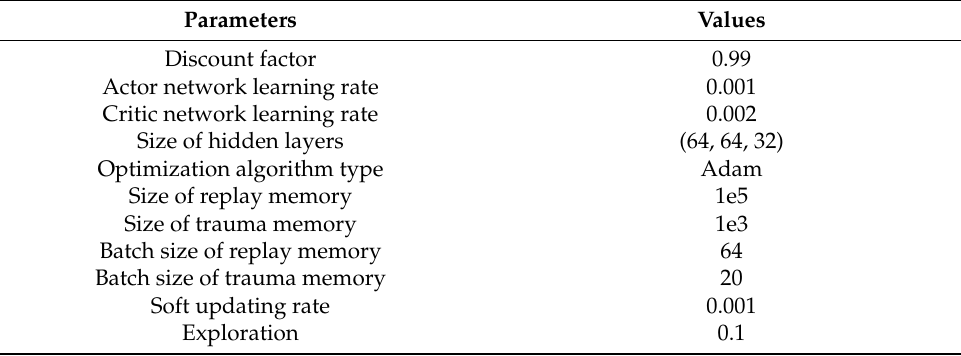
Table 2. Parameter setting of the DRL